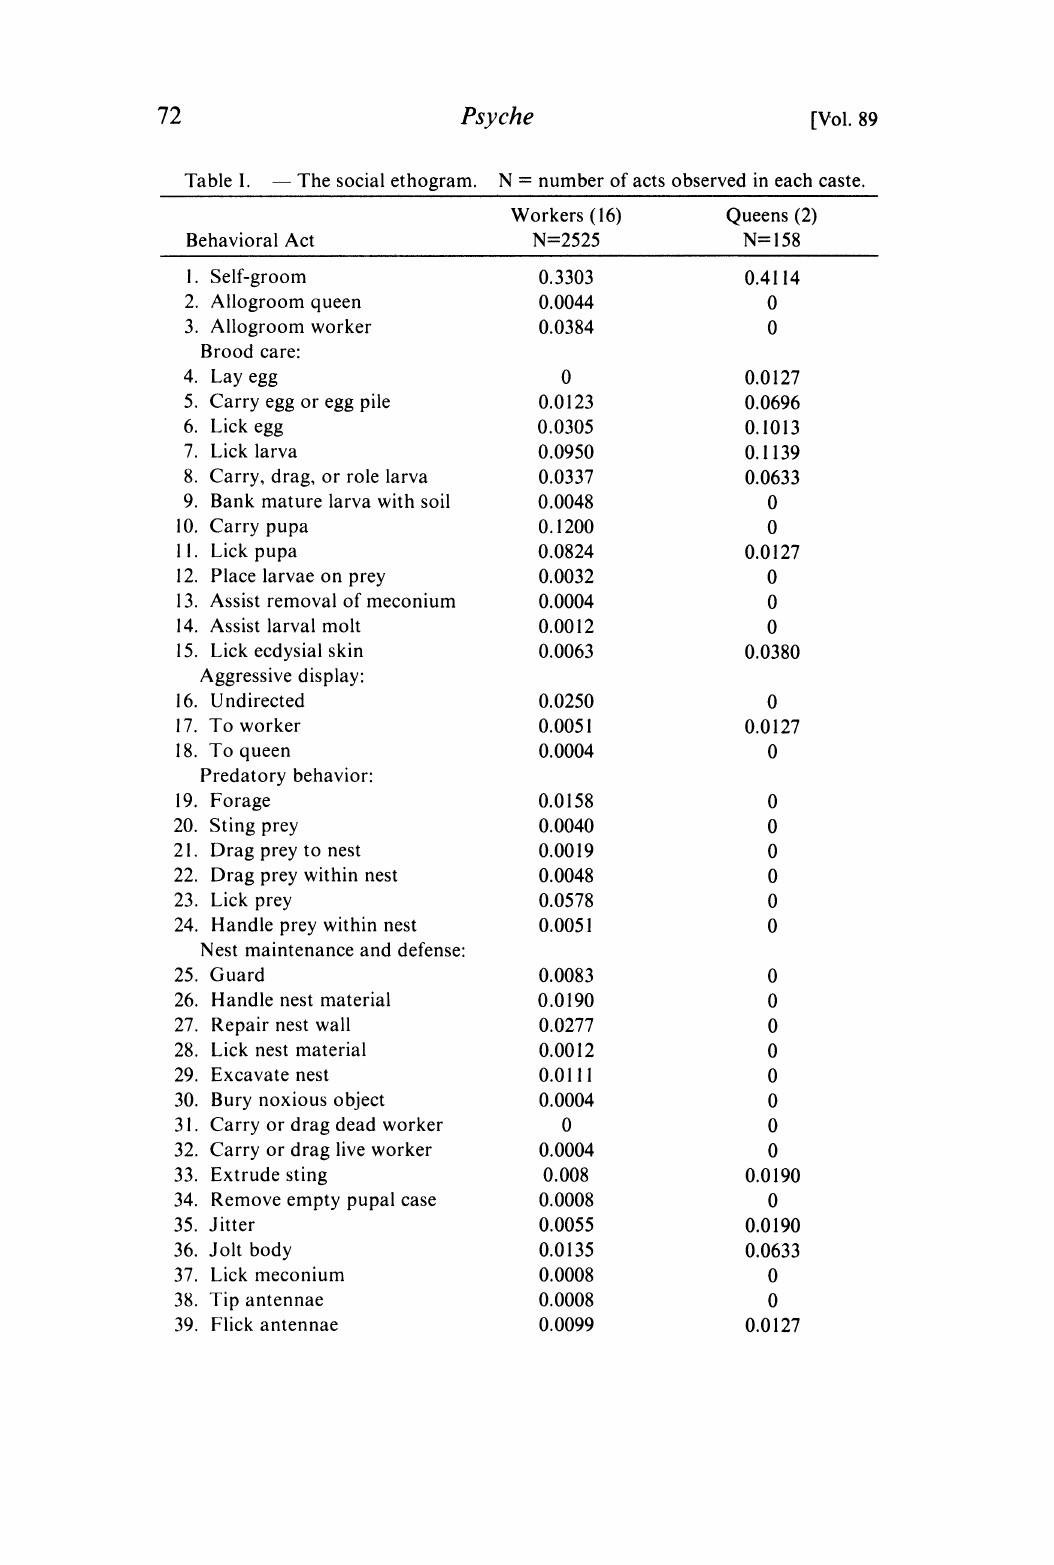
The social ethogram. N number of acts observed in each